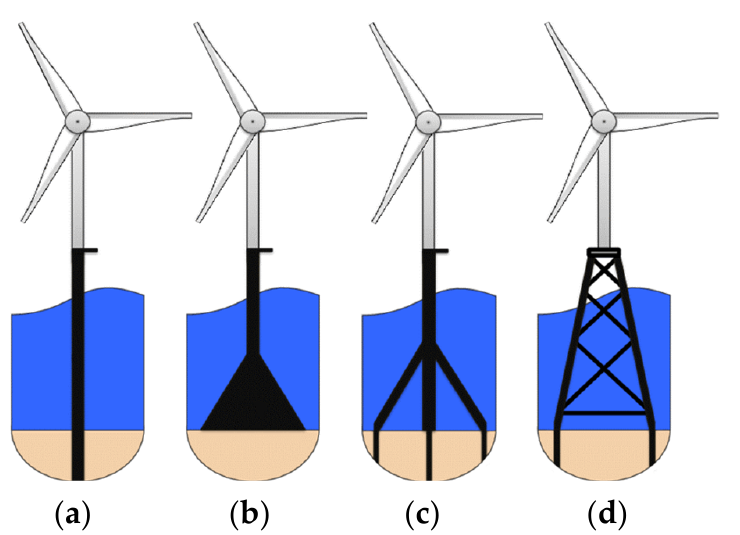
Figure 1. Various bottom-fixed substructure types: ( a ) Monopile; ( b ) gravity-base; ( c ) tripod; ( d ) jacket [34].